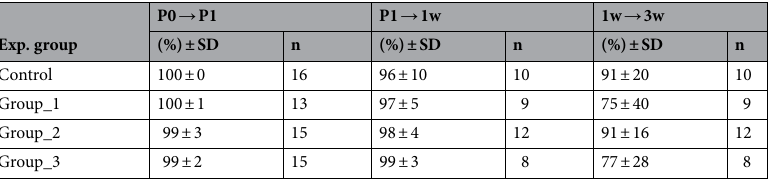
Table 3. Effects of LHRHa on offspring viability. Mean percent viability (%) of all litters from each experimental group and their respective standard deviations (± SD) are shown. n indicates the number of mouse mothers.